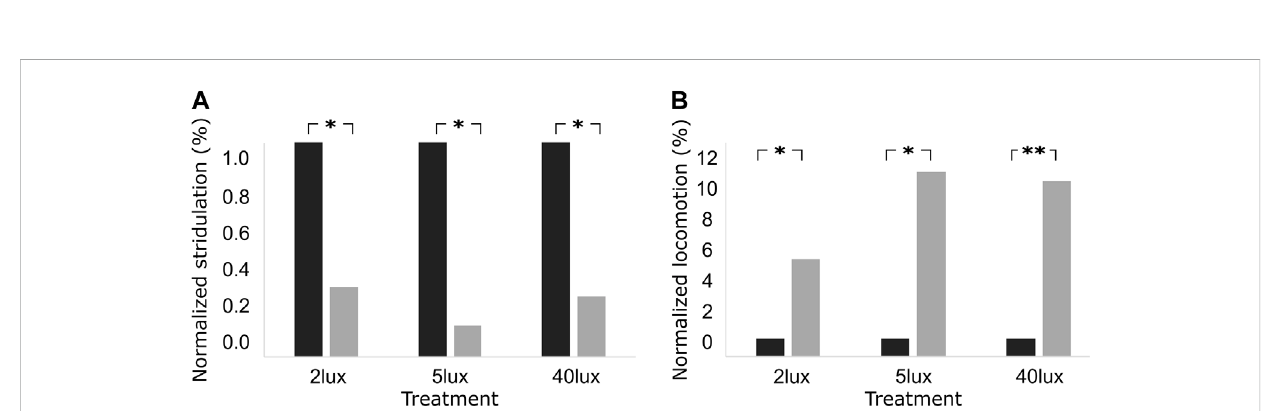
FIGURE 4 Percentage of normalized level of (A) stridulation, and (B) locomotion behavior, one hour before (black), and one hour after (grey) the light pulse treatment of 2 lux, 5 lux, and 40 lux. * p < 0.05, ** p < 0.01, representing one-tailed p